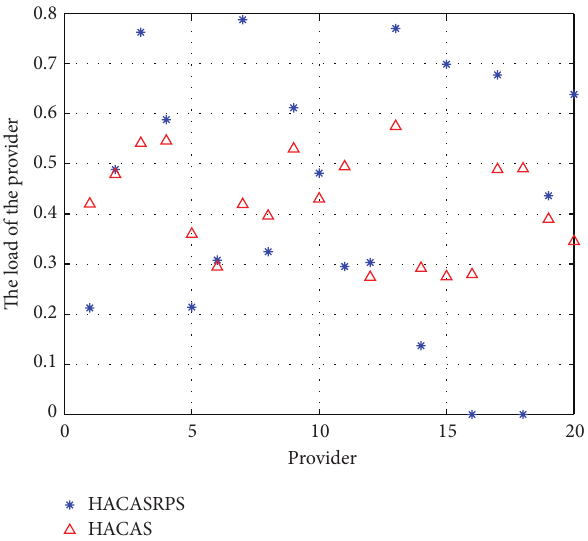
Figure 8: The load of all the providers of the 10th ant’s solution at the 5th cycle.